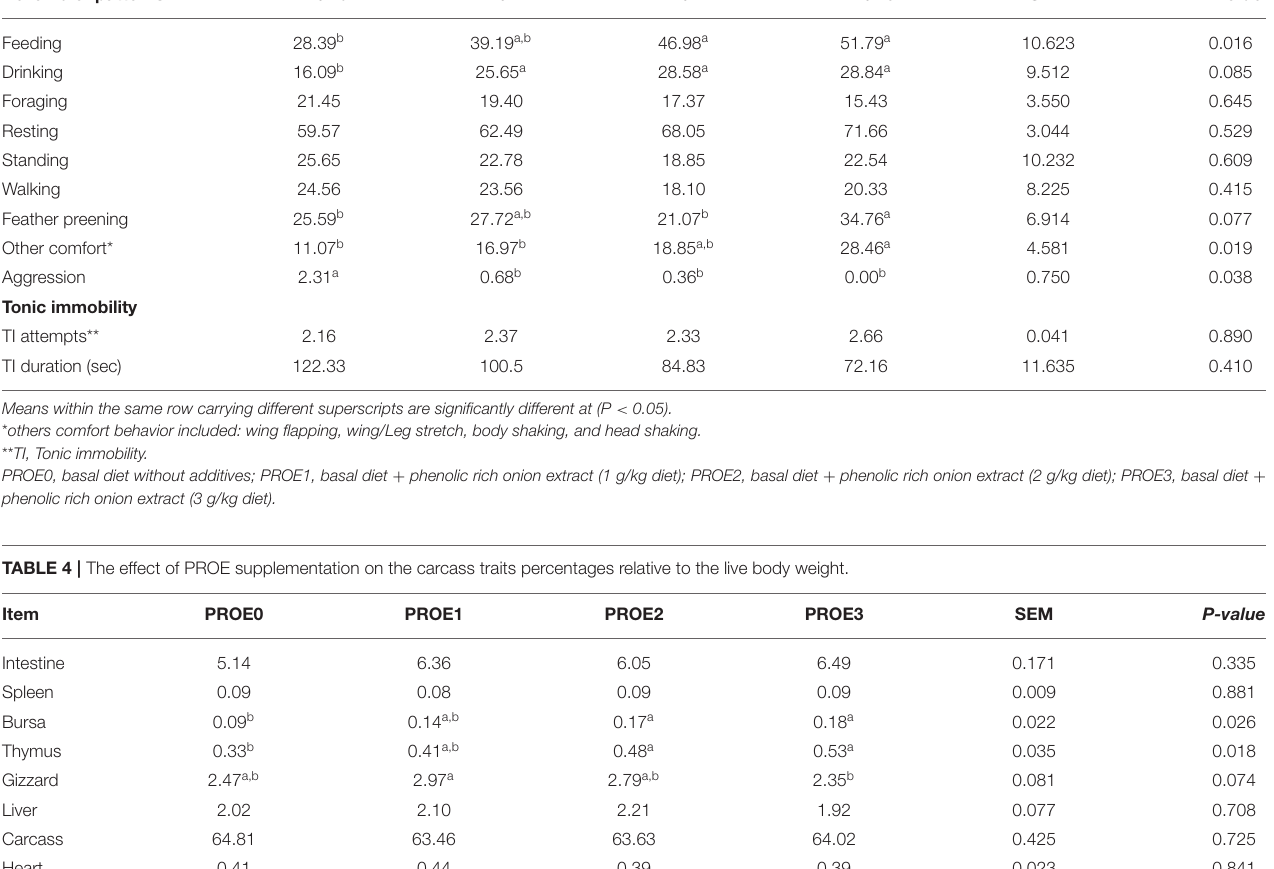
TABLE 3 | The effect of PROE supplementation on various behaviors (% means of broilers/5min) and tonic immobility of broiler chickens. Behavioral patterns PROE0 PROE1 PROE2 PROE3 SEM P- Value Feeding 28.39 b Drinking Foraging